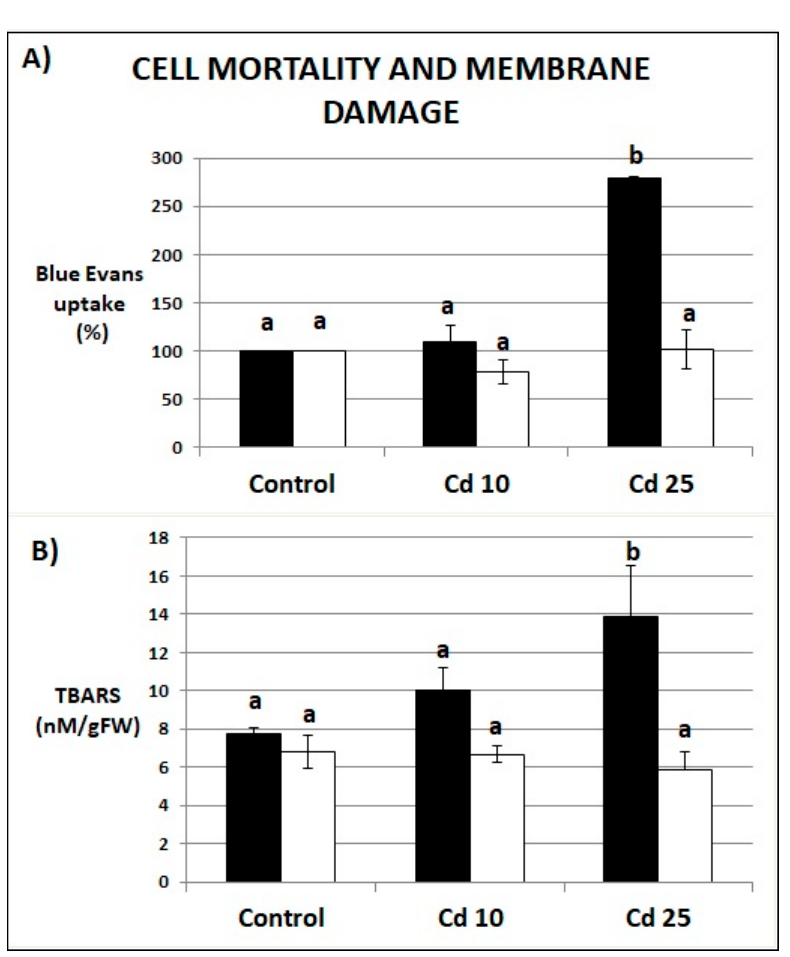
Figure 4. Evans Blue uptake indicating cell death expressed as percentage in relation to the control ( A ) and lipid peroxidation expressed as increase in thiobarbituric acid reactive substances (TBARS) level ( B ) in seedlings after 48 h of Cd stress (black bars) and after 7 days of recovery period (white bars). Results are the means of 3–4 independent experiments ± SE . Results showing no statistically significant differences in relation to control by p = 0.05 are marked with the same letter.